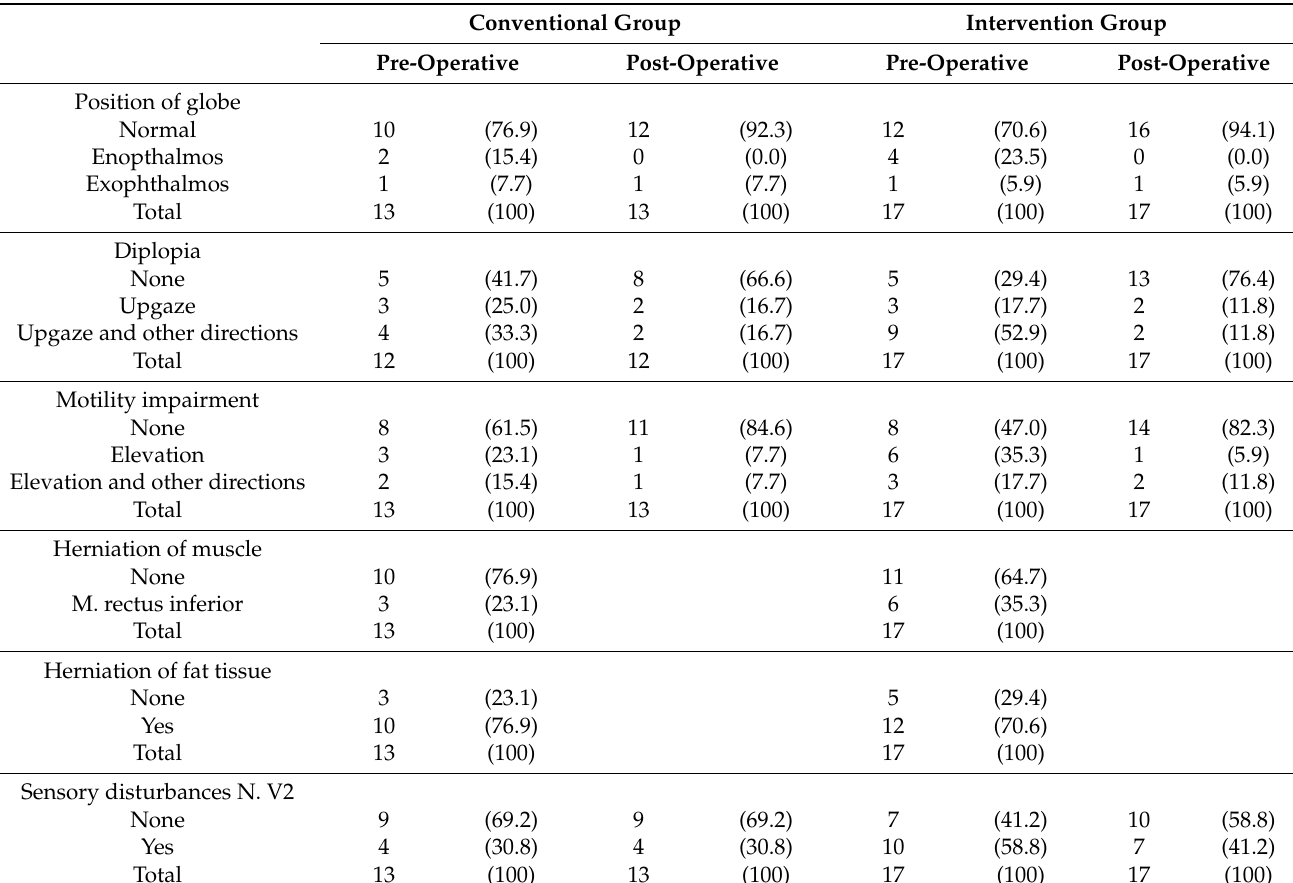
N. V2: Maxillary nerve (second division of the trigeminal